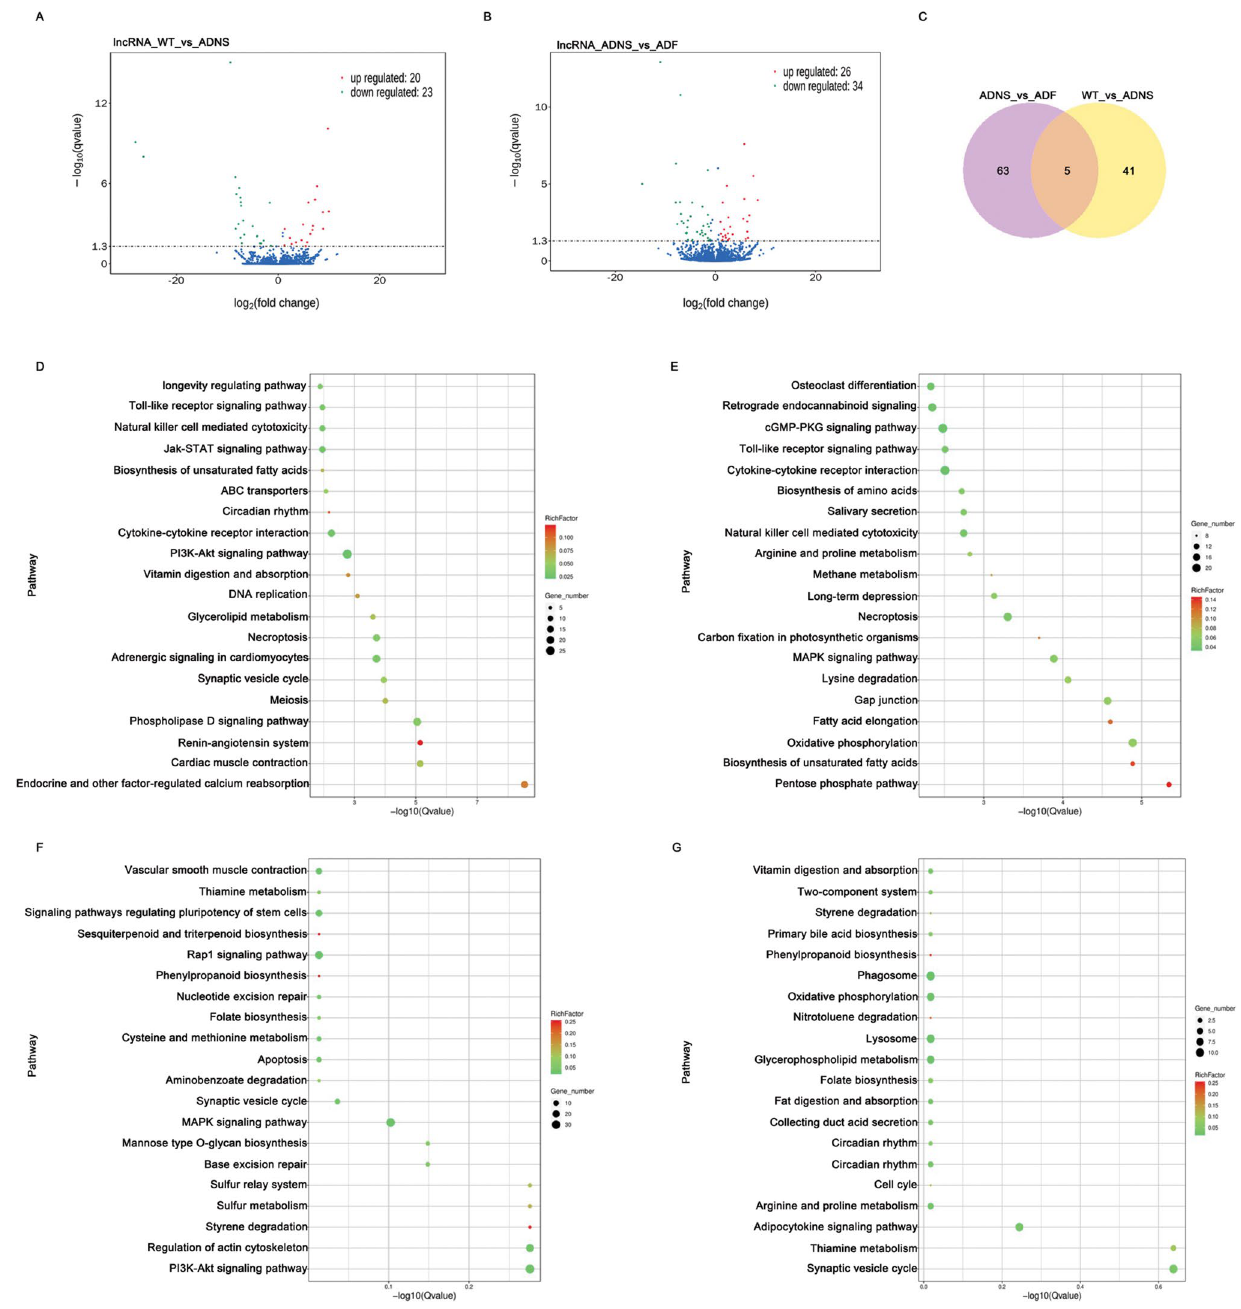
Figure 3. Differentially expressed lncRNAs in hippocampal tissues from mice in each group. ( A ) The number of upregulated (22) and downregulated (24) lncRNAs between ADNS and WT are shown. (B) The number of upregulated (29) and downregulated (39) differentially expressed lncRNAs between ADF and ADNS are shown. (C) Venn showed 5 lncRNAs at the intersection of ADNS versus ADF and WT versus ADNS. (D) KEGG analysis involving the top 20 terms of differentially expressed lncRNA co-located with mRNA in WT versus ADNS. Most genes focus in PI3K-AKT signal pathway. (E) KEGG analysis involving the top 20 terms of differentially expressed lncRNA co-located with mRNA in ADNS versus ADF. Most genes focus in cytokine- cytokine receptor interaction and cGMP-PKG signaling pathway. (F) KEGG analysis of differentially expressed lncRNA co-expressed with mRNA in WT versus ADNS. Most genes focus on the pathway of PI3K-Akt, MAPK, regulation of actin cytoskeleton and Rap1 signaling pathway. (G) KEGG analysis of differentially expressed lncRNA co-expressed with mRNA in ADNS versus ADF. Most genes focus on the pathway of phagosome, synaptic vesicle cycle and adipocytokine signaling pathway (KEGG pathways: https:// www. kegg. jp/ kegg/ kegg1.